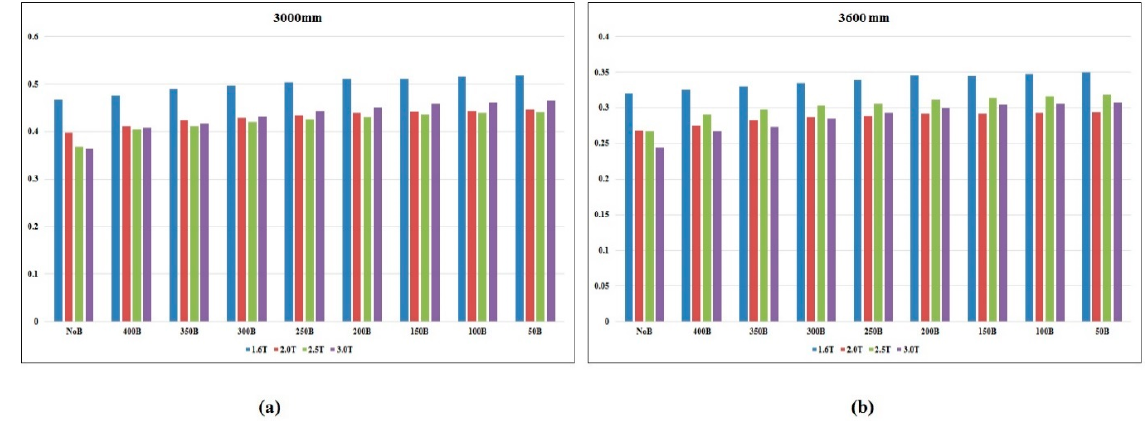
Figure 18. Ultimate load capacities based on thickness and reinforcement spacing for ( a ) 3000 mm models and ( b ) 3600 mm models.